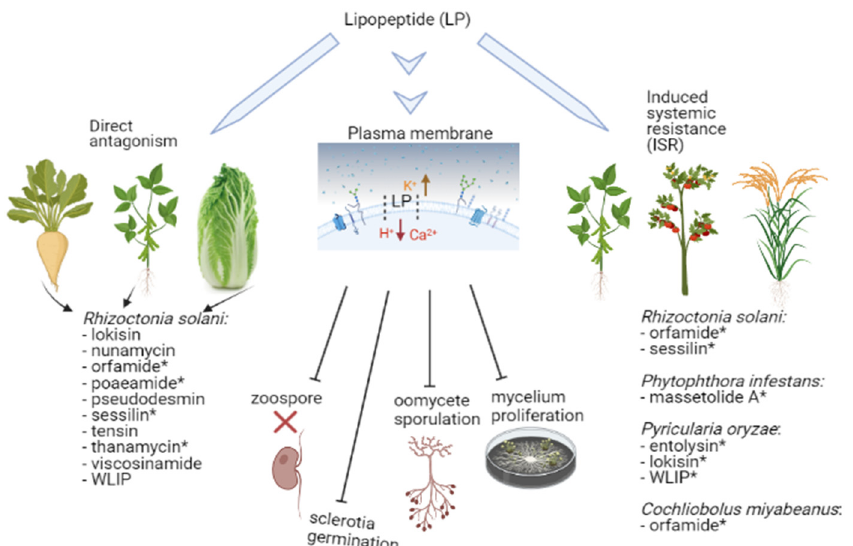
Figure 6. Scheme Showing the Membrane Interaction of LPs Together with their Bioactivity Routes via Direct Antagonism and Induced Systemic Resistance (ISR). LPs perturb the membrane barrier resulting in an influx of H + and Ca 2+ together with an efflux of K + . In in vitro tests, LPs successfully lyse zoospores and block sclerotia germination, oomycete sporulation/germination and mycelium proliferation. In direct antagonism, diverse LPs mediate R. solani suppression on bean, Chinese cabbage and in in vitro tests. For ISR, LPs induce resistance against R. solani on bean, Phytophthora infestans on tomato, Pyricularia oryzae on rice and Cochliobolus miyabeanus on rice. Asterisks (*) indicate LPs that were tested in planta while the other LPs were tested in the absence of a plant host. 7.2. Microbial Competition: Bacterial Mycophagy and White Line-in-Agar